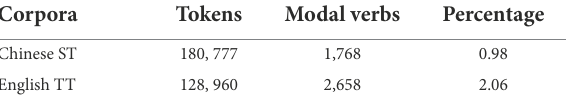
TABLE 3 Comparison of the total of modal verbs in ST and TT.